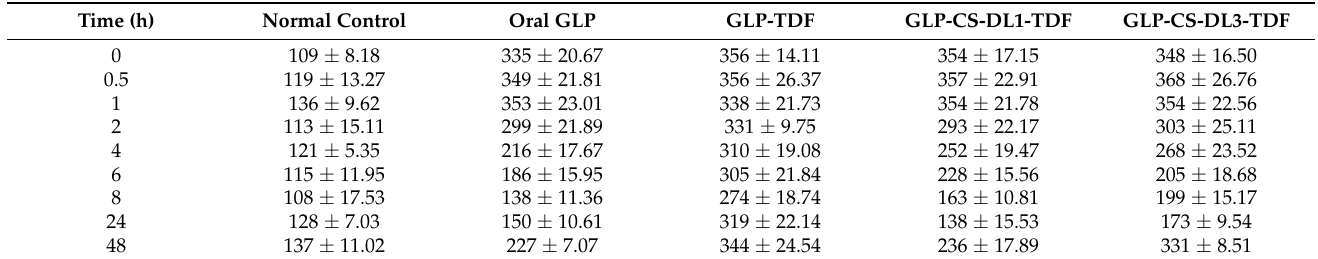
Table 7. Effect on blood glucose levels in STZ-induced diabetic rats (mean ± SD). Time (h) Normal